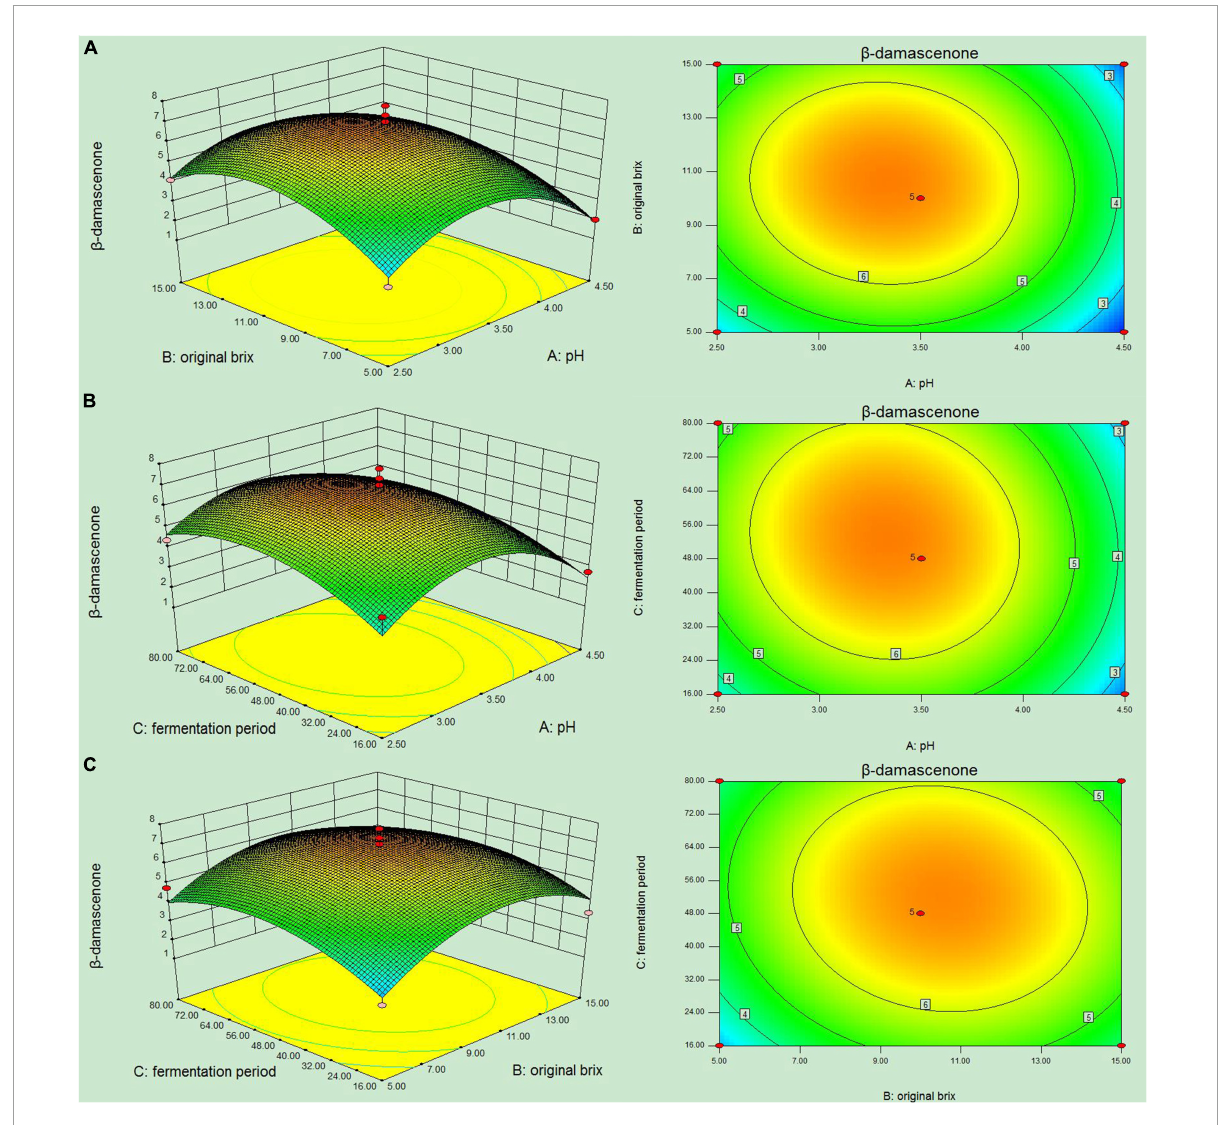
FIGURE5 Response surface (3D) and contour plots (2D) for the β -damascenone content. (A) Effects of the initial pH and original Brix on the β -damascenone content. (B) Effects of the initial pH and fermentation period on the β -damascenone content. (C) Effects of the original Brix and fermentation period on the β -damascenone